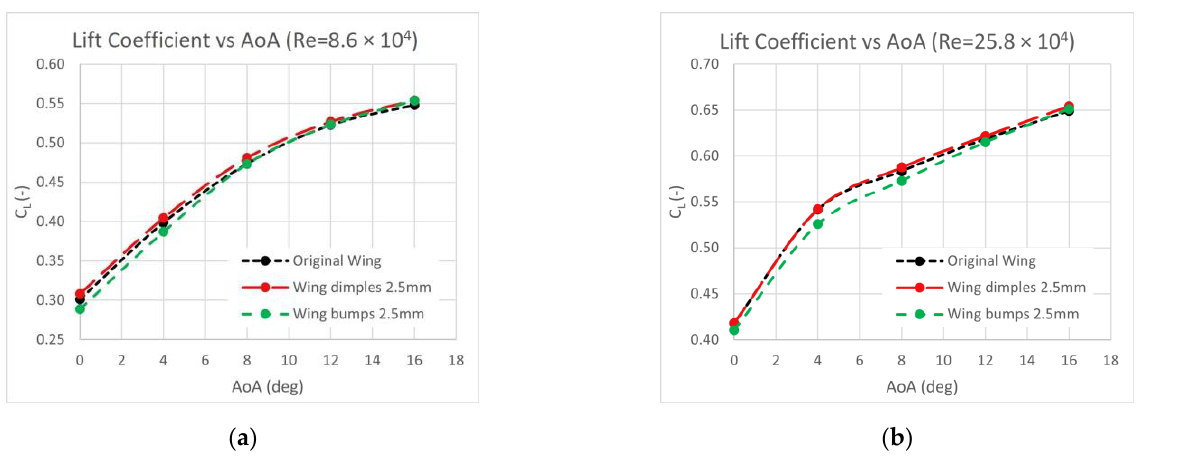
Figure 9. Lift coefficient of the three wings under ( a ) Re = 86,000 and ( b ) Re = 258,000.